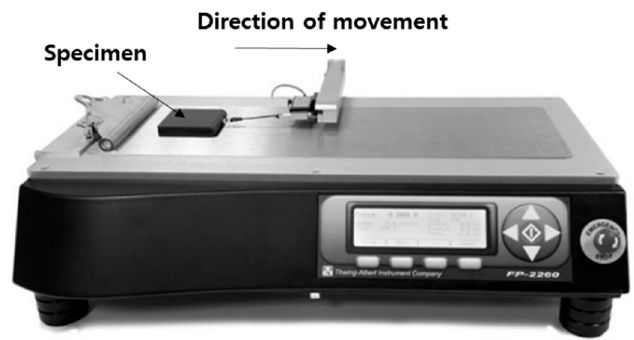
Figure 4. Equipment for measuring the friction coefficient.